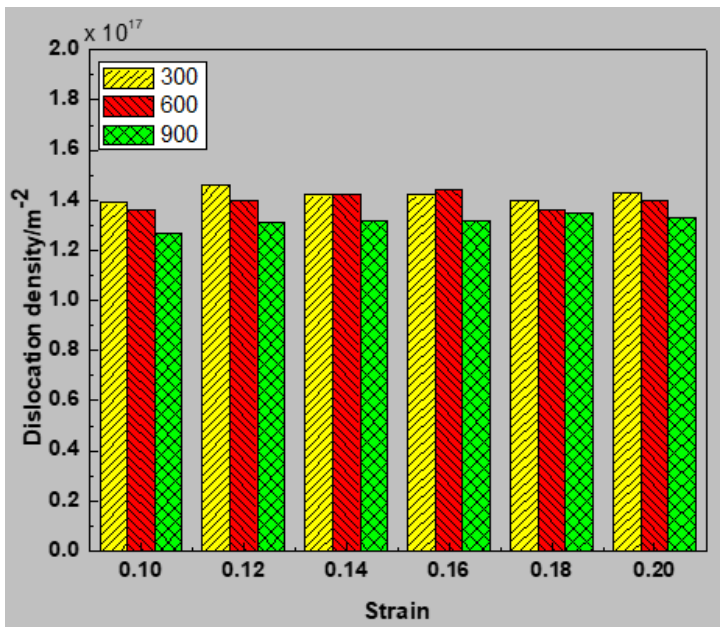
Figure 16. Volume fraction of twins and stacking faults (hcp) in the sample with an average grain size of 7.7 nm for various strains and temperatures (300, 600, and 900 K).